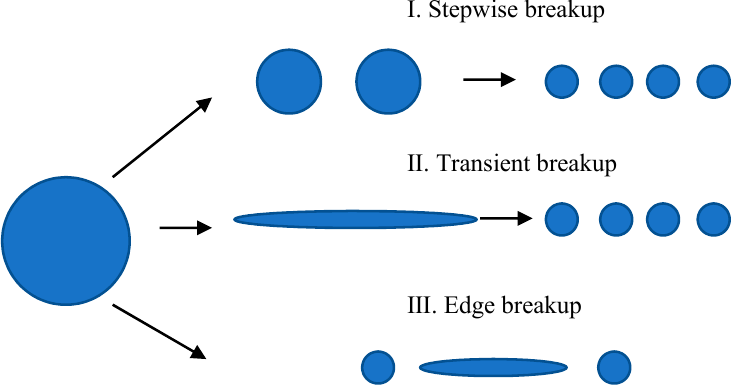
Fibers 2019 , 7 , x FOR PEER REVIEW Figure 11. Breakup mechanisms of dispersed droplets. Figure 11. Breakup mechanisms of dispersed droplets.